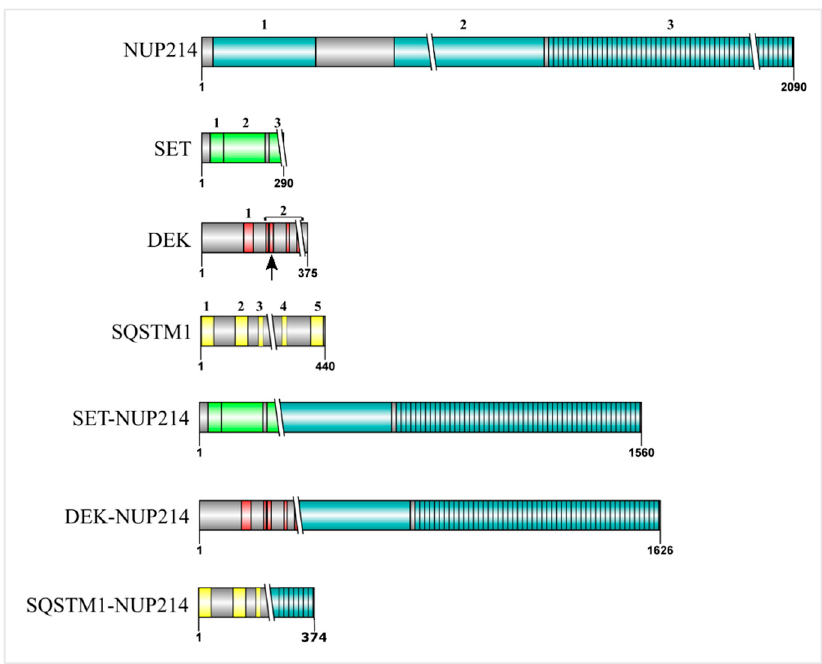
Figure 2. Schematic representation of NUP214 and its binding partners in leukemogenic NUP214 fusion proteins. The numbers indicate the specific domains of each protein. Crossing lines ( \\ ) represent the breakpoints in the respective fusion protein. NUP214: 1— β propeller, 2—Coiled coil, 3-